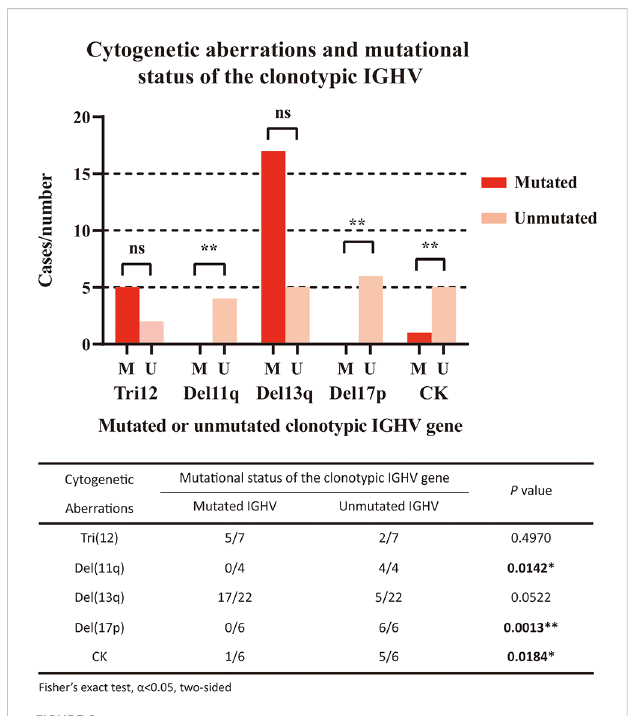
FIGURE 2 Correlation of cytogenetic aberrations and mutational status of the clonotypic IGHV gene. The fi ve cytogenetic aberrations detected included FISH aberrations (trisomy 12/Tri12, deletion of 11q/Del11q, deletion of 13q/Del13q, deletion of 17p/Del17p) and the aberrant karyotype (complex karyotype/CK). In the right panel, red columns represent cases with mutated IGHV regions, while pink columns represent cases with unmutated IGHV regions. The statistical analysis was performed using Fisher ’ s exact test, a <0.05 (two-sided). Ns, nonsigni fi cant. * P <0.05. ** P <0.01.